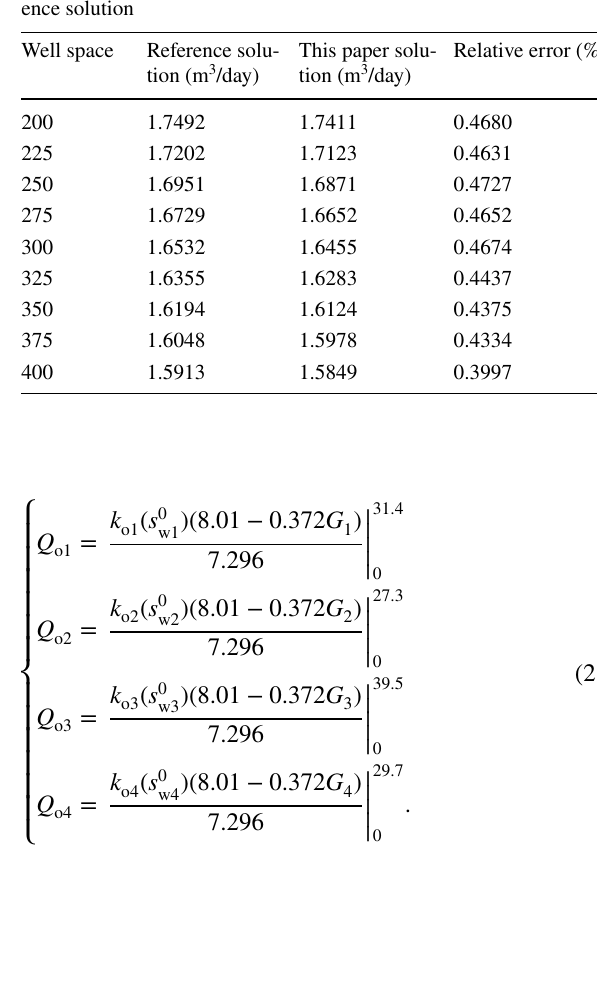
Table 3 calculation results between this paper solution and the